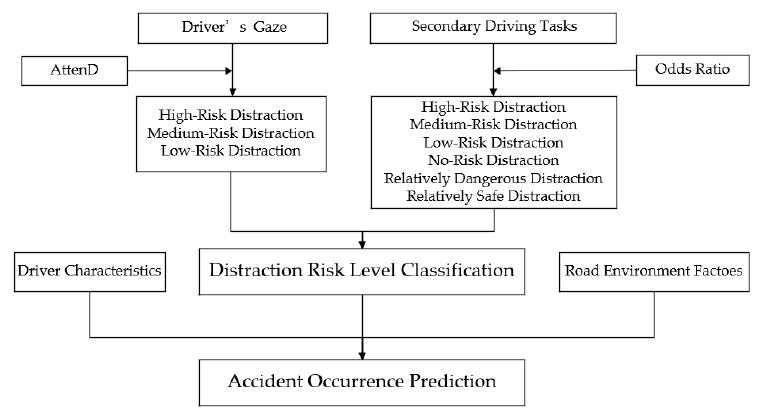
Figure 1. Logical Figure 1. Logical framework.